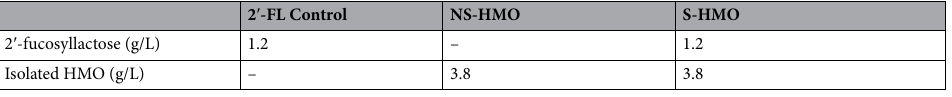
Table 2. Concentrations of HMO used in fermentation